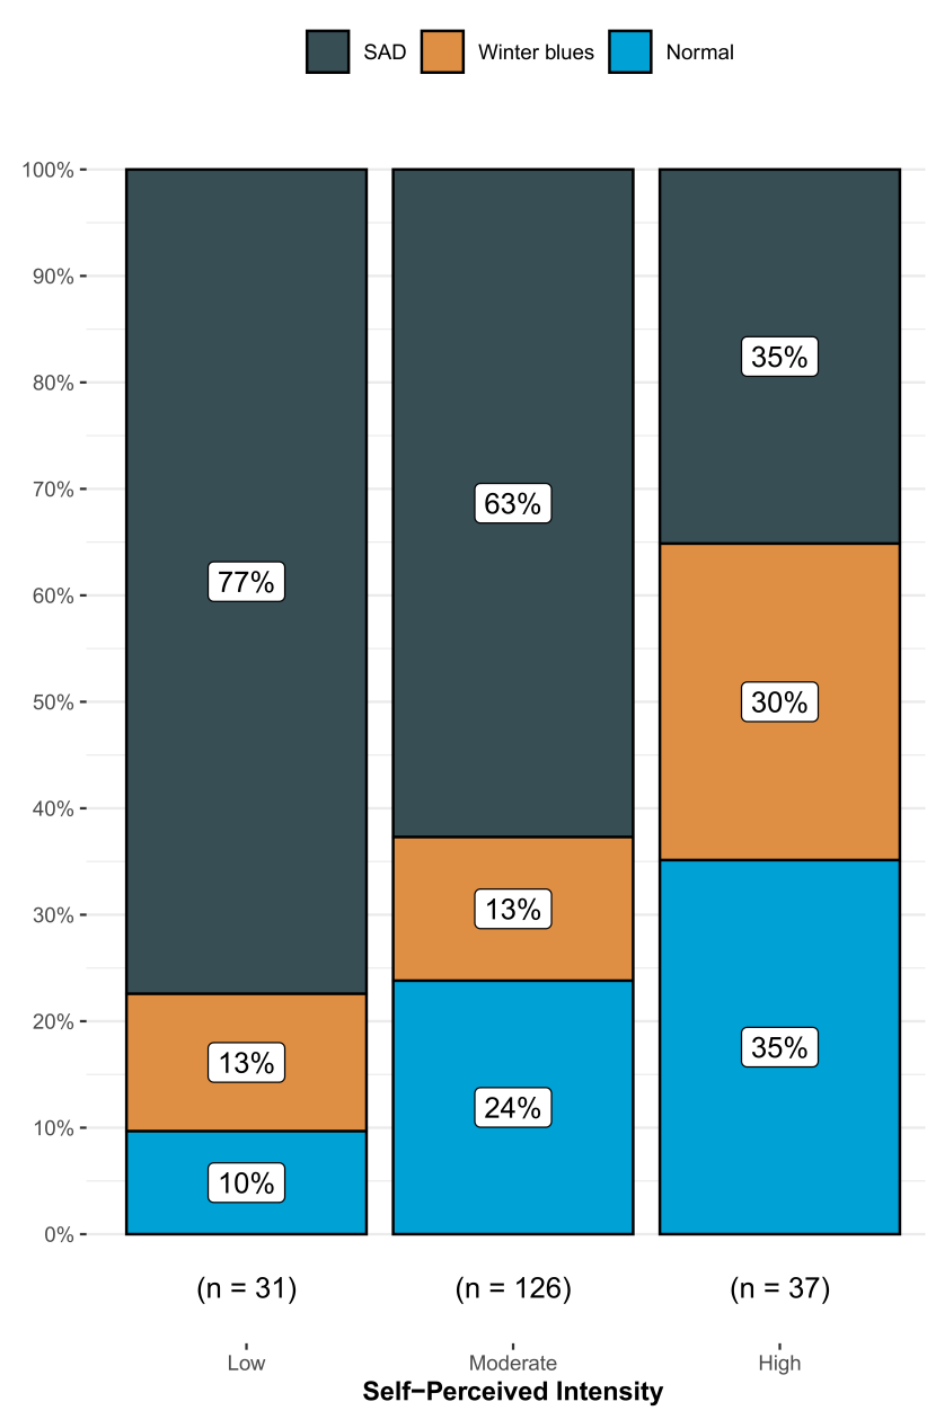
Figure 1. Cumulative bar plots indicate the observed proportions between the levels of SSI and the self-perceived intensity of physical activity. The SSI had a proportional effect on the summer pattern variable. Subjects classified within the SAD group scored higher on the summer pattern than the winter blues and normal groups ( χ 2 (2) = 20.76, p < 0.001, ˆ (cid:101) = 0.06 and CI95% [0.03, 1.00]). A Kruskal − Wallis similar trend was observed for the SSI on the winter pattern, where the SAD group recorded higher scores on the winter pattern than those in the winter blues and normal groups ( χ 2 (2) = 52.28, p < 0.001, ˆ (cid:101) = 0.15 and CI95% [0.09, 1.00]); those with a mixed- Kruskal − Wallis type pattern had a higher proportion of people with SAD compared to those with a